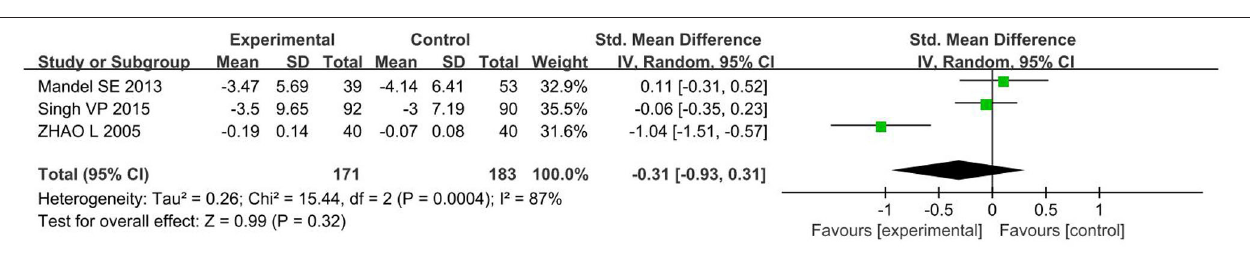
FIGURE 3 | The effects of art therapy on anxiety.